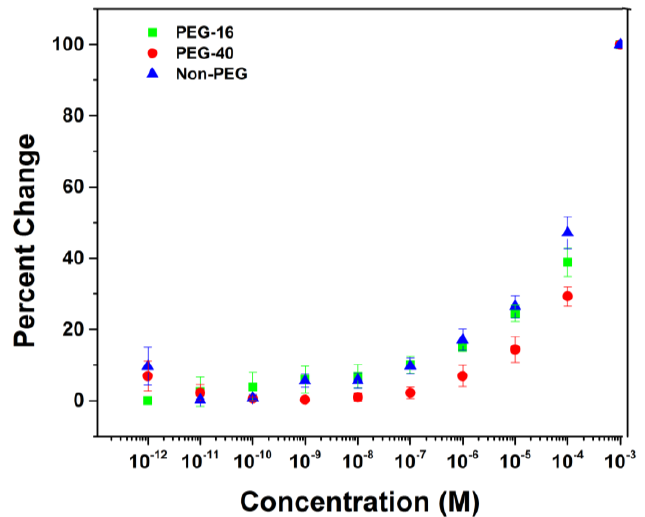
Figure 6. Comparison of polymers functionalized with different lengths of